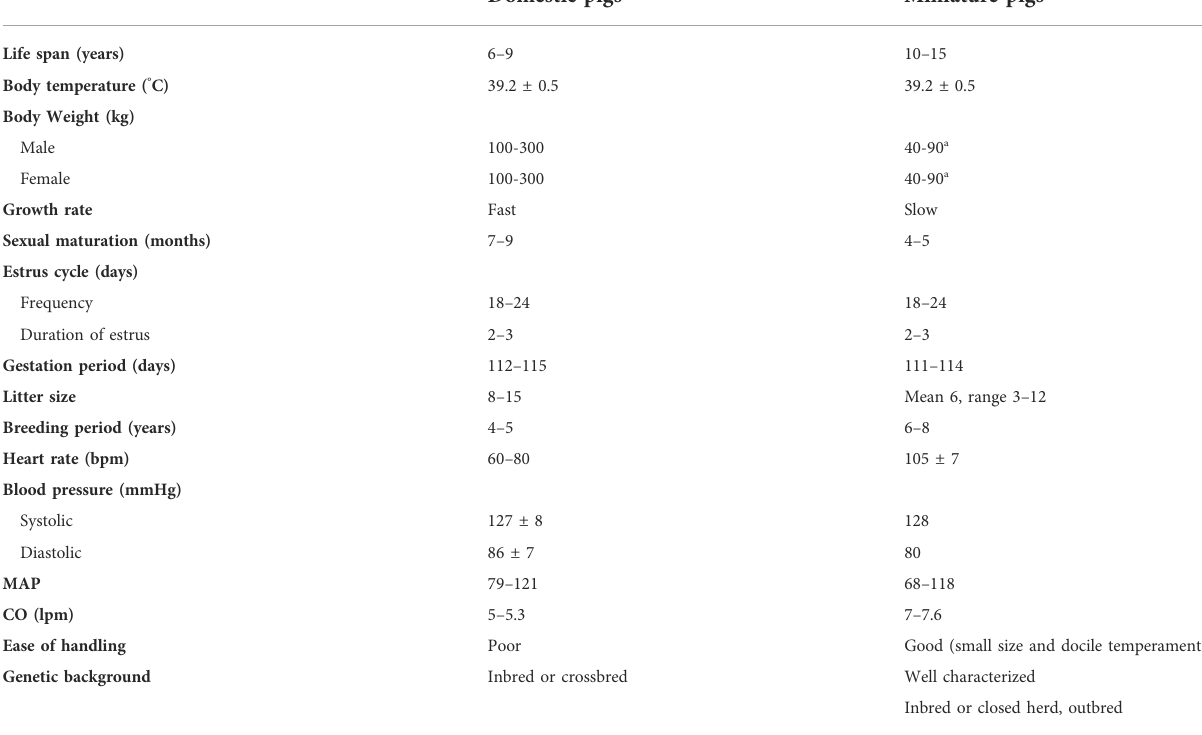
TABLE 1 Domestic pigs vs. Miniature pigs.